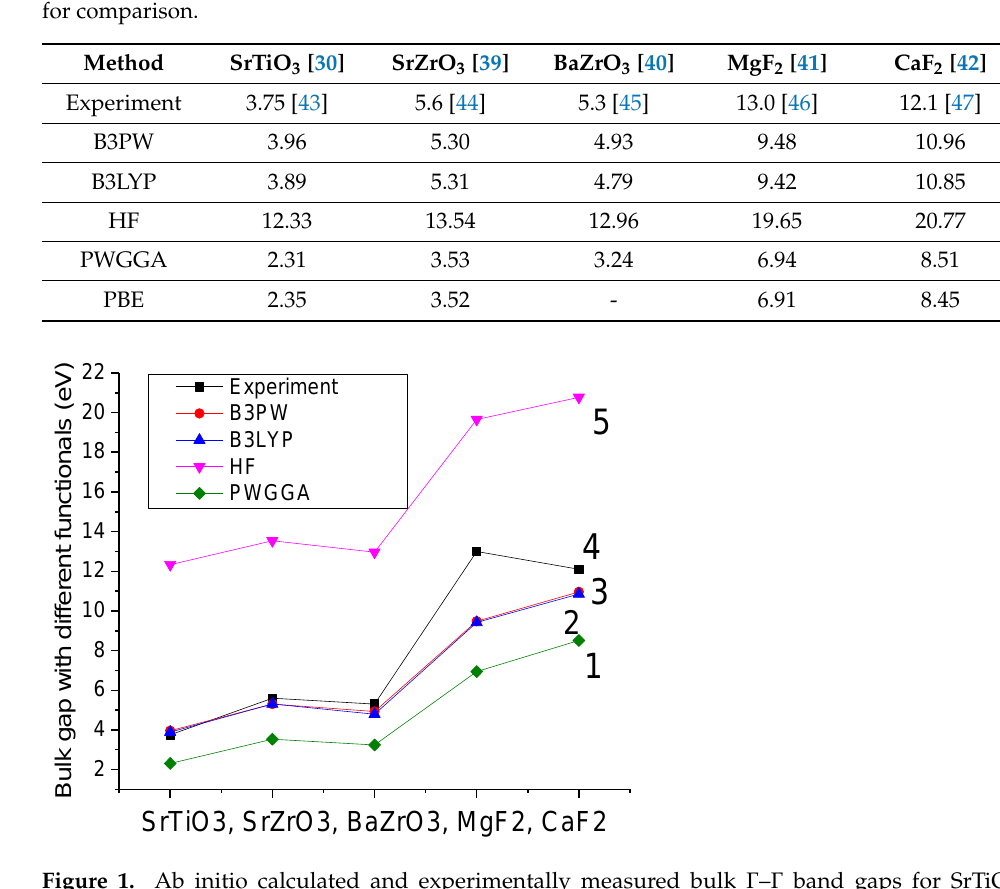
Figure 1. Ab initio calculated and experimentally measured bulk Γ–Γ band gaps for SrTiO 3 , SrZrO 3 , BaZrO 3 , MgF 2 and CaF 2 obtained by means of different exchange–correlation functionals: (1) PWGGA; (2) B3LYP; (3) B3PW; (4) Experiment; (5) HF.